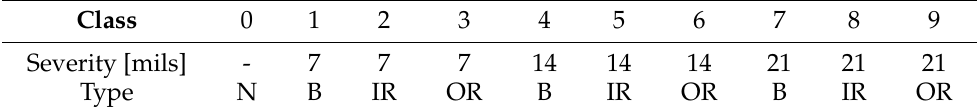
Table 1. Classes in the CWRU